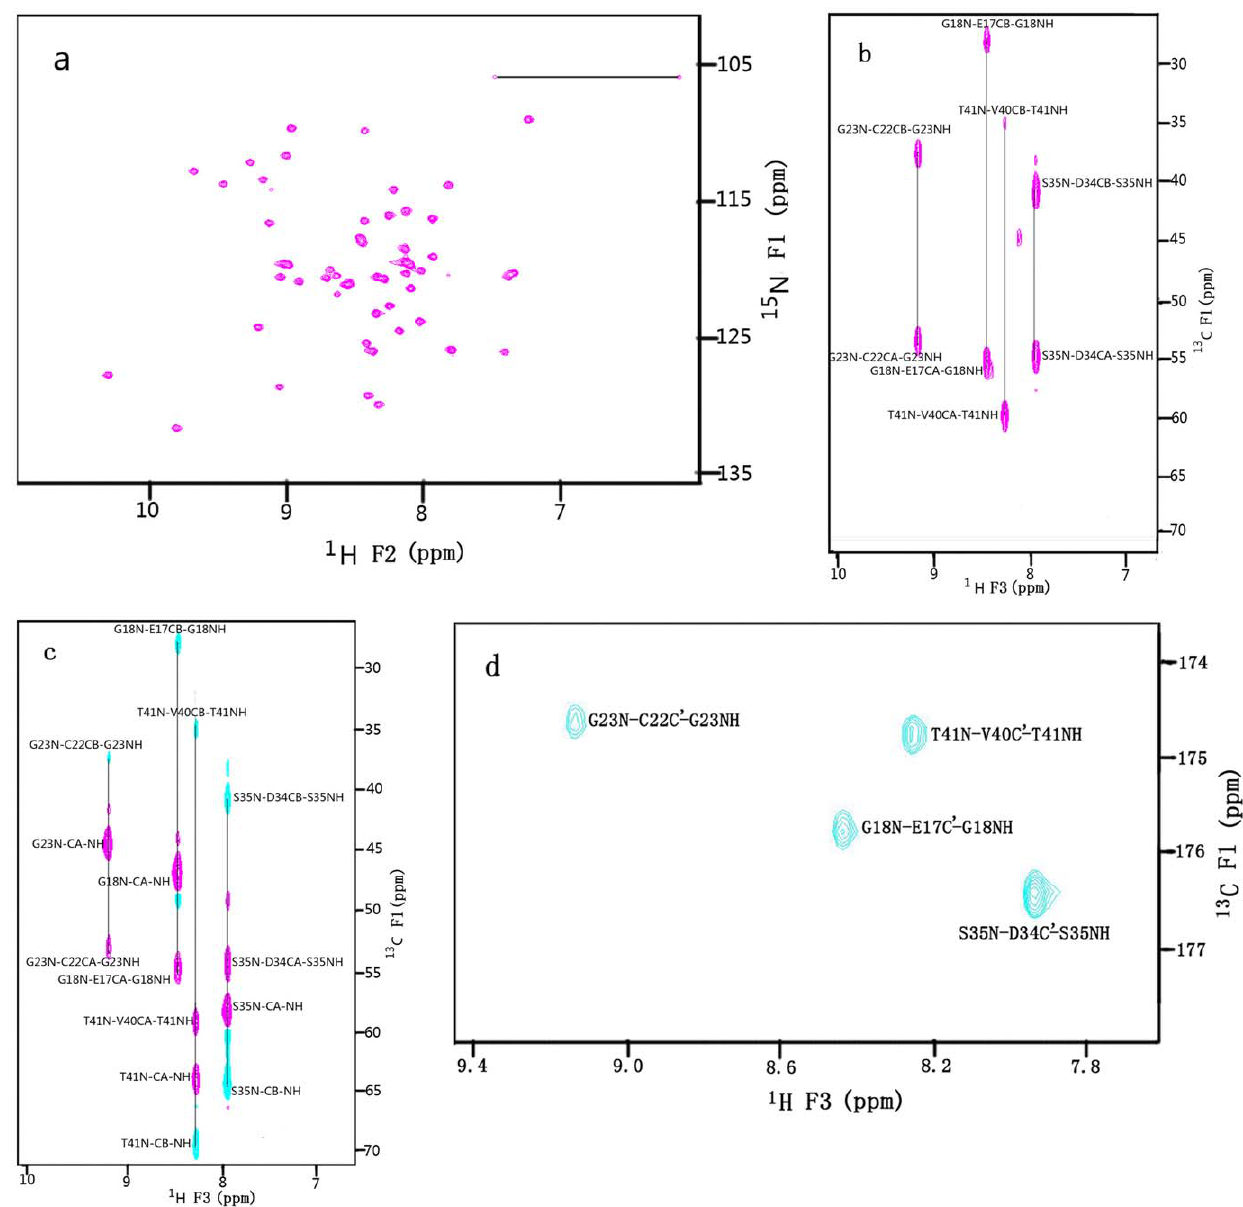
Figure 4. The 600MHz NMR spectra of 2.0 mM 15 N, 13 C-labeled RGD-hirudin (1–66) in 20 mM sodium phosphate buffer, pH 7.4. a. 15 N(F1 axis)-NH(F2 axis) region of the 2D 15 N- 1 H Overbodenhausen correlation spectrum, b, c & d are selected 13 C(F1)- 1 H(F3) planes at d [ 15 N(F2)]=116.4 ppm of the 3D CBCA(CO)NH, CBCANH and HNCO spectra of RGD-hirudin (1–66) respectively. Sequential connectivities for four residues are indicated.